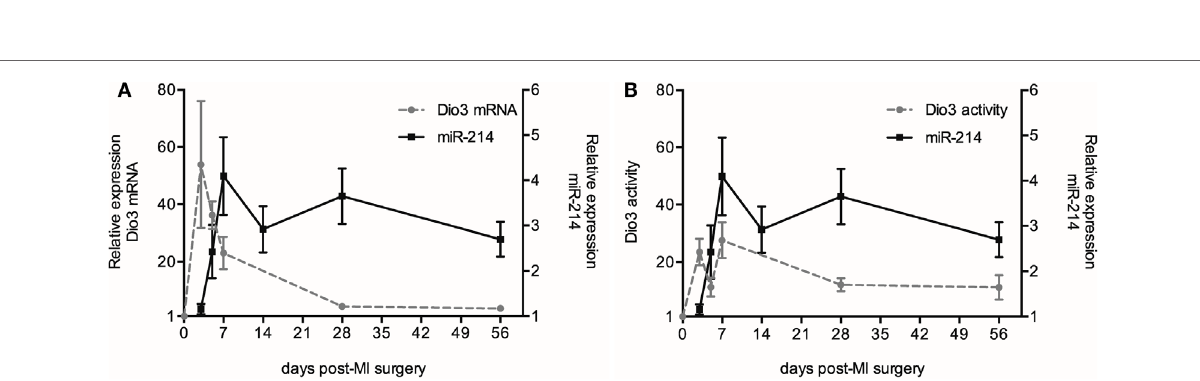
FigUre 5 | Dio3 protein and mir-214 are co-expressed . Representative images of immunohistochemical staining for Dio3 (a) and miR-214 in situ hybridization (B) in sequential sections of LV tissue 7 days post-MI. The indicated area shows a group of cardiomyocytes expressing both Dio3 protein and miR-214, with adjoining cells negative for both. Bar = 100 μ